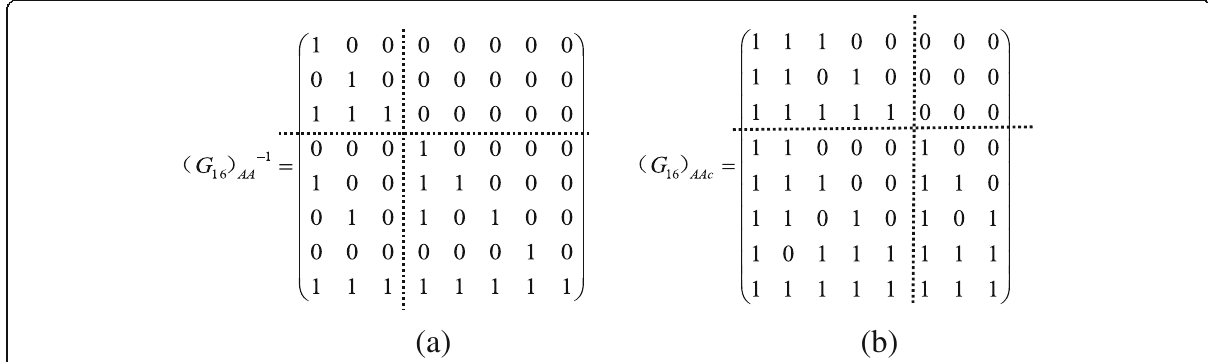
Fig. 9 Matrix segmentation at N = 16: The matrix ( G 16 ) AA − 1 and ( G 16 ) AAc in a and b can be divided to obtain the submatrix with all elements of zeros, respectively. To further discussion general case, a can be segmented into submatrices of g 1 , g 2 , g 3 , and g 4 shown in Fig. 10a. The submatrix g 2 is a zero matrix